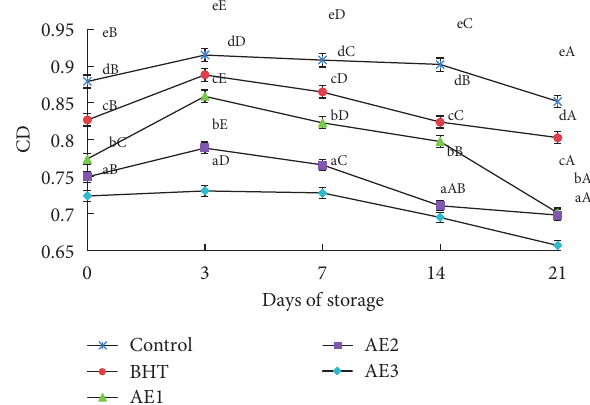
Figure 6: Effect of the aqueous pomegranate peel extract on conjugated dienes ( μ mol/mg of meat) of minced beef meat during storage at 4 °